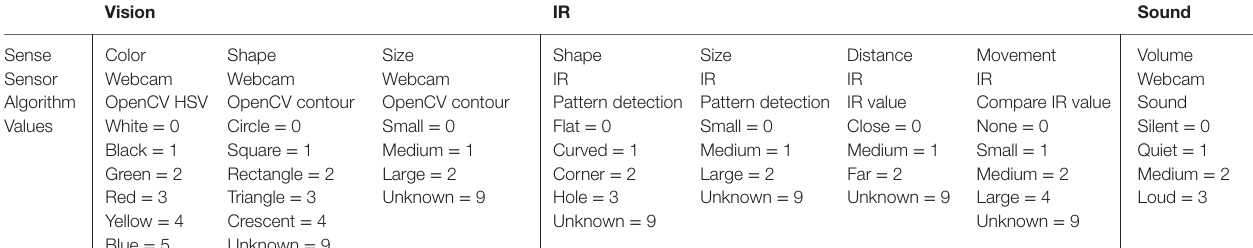
TaBle 1 | The different sensory modalities and their implementation and